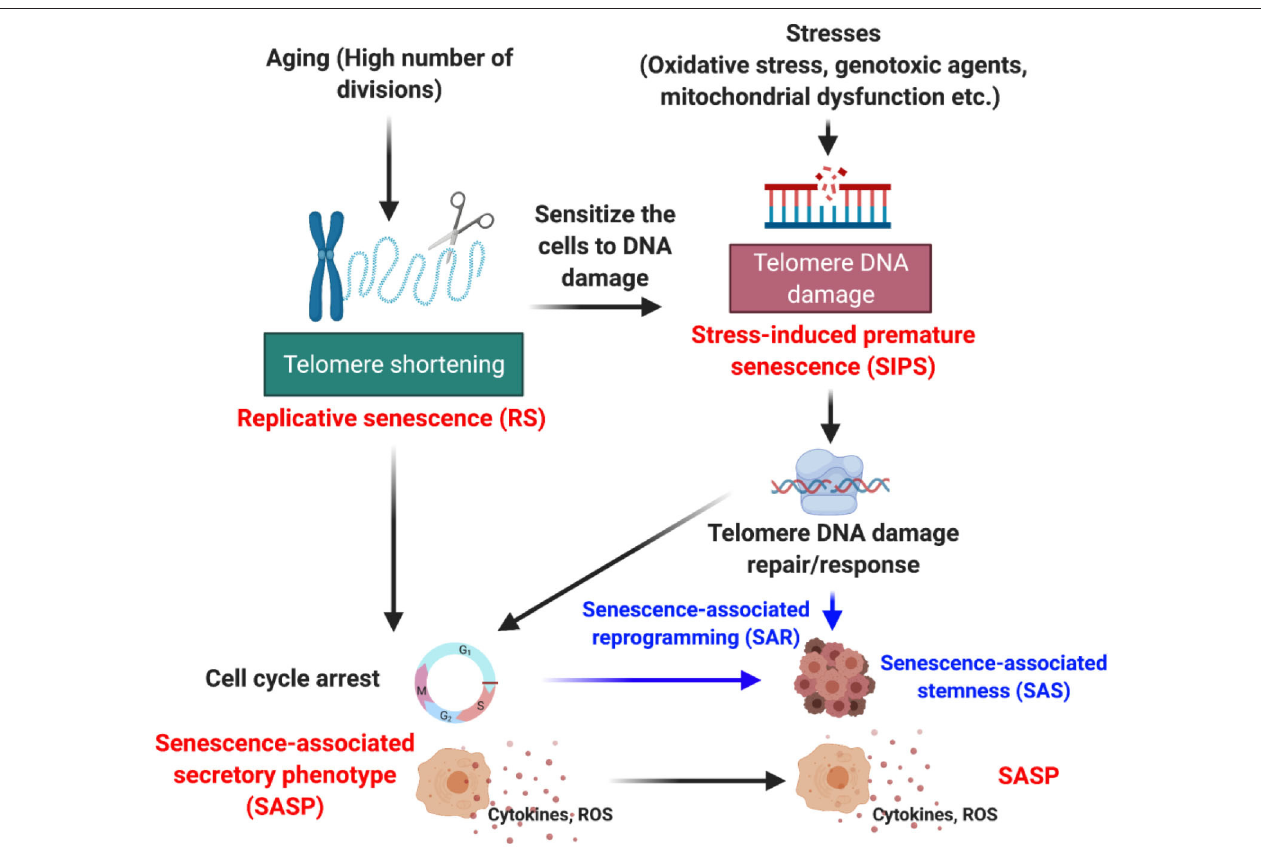
FIGURE 1 | Various forms of